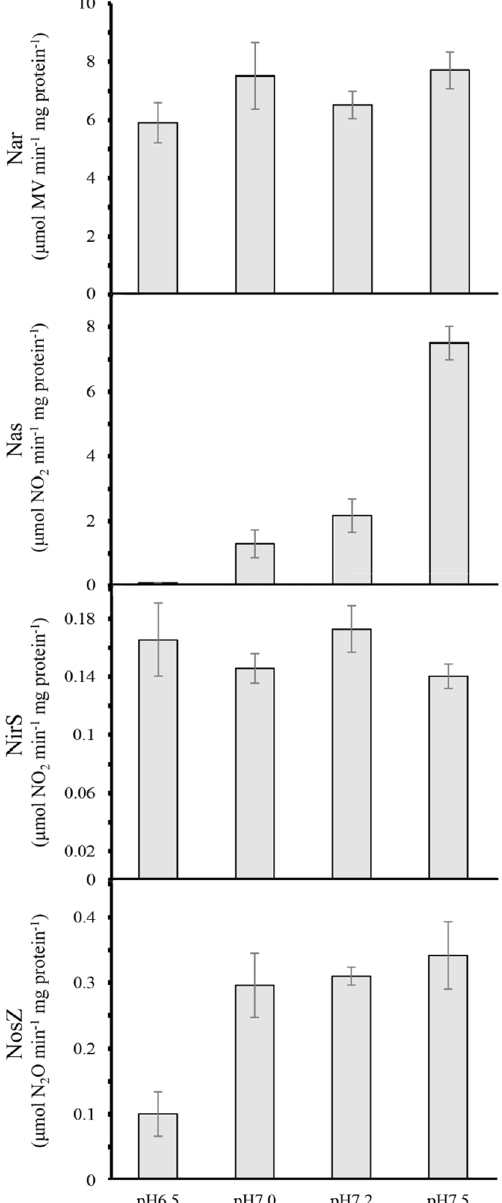
Figure 4. Effect of pH on denitrification enzymes and assimilatory nitrate reductase in P. denitrificans . Cells were grown under anaerobic conditions with nitrate (30 mM) as nitrogen and energy source at the indicated pHs. Enzymic activities of respiratory (Nar) and assimilatory (Nas) nitrate reductases, nitrite reductase (NirS) and nitrous oxide reductase (NosZ) were determined as described in “Materials and Methods”. Error bars correspond to data from three independent replicates (n =